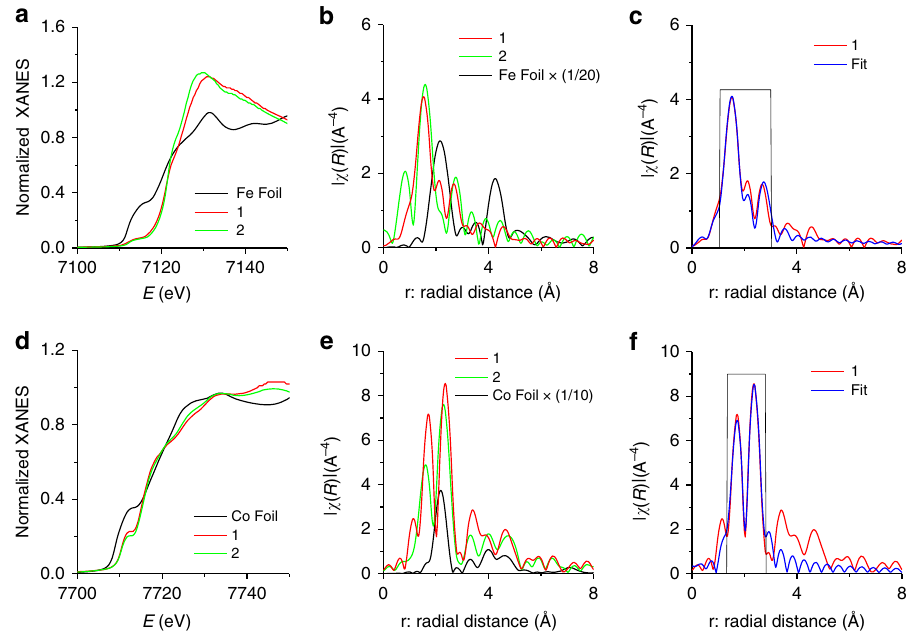
Fig. 3 X-ray absorption spectra. a – c Fe K-edge. d – f Co K-edge. a , d XANES spectra for Fe K- and Co-K-edges. b , e Fourier transform (FT) of the EXAFS spectra in real space at Fe K- and Co K-edges. c , f FT – EXAFS spectra in r-space and the corresponding least-squares fi t (black rectangular line) for fi rst and second shells. 1 : Fe 3 Co(PO 4 ) 4 @rGO; 2 : FeCo(PO 4 ) 2 @rGO. Source data for a – f are provided as a Source Data fi le